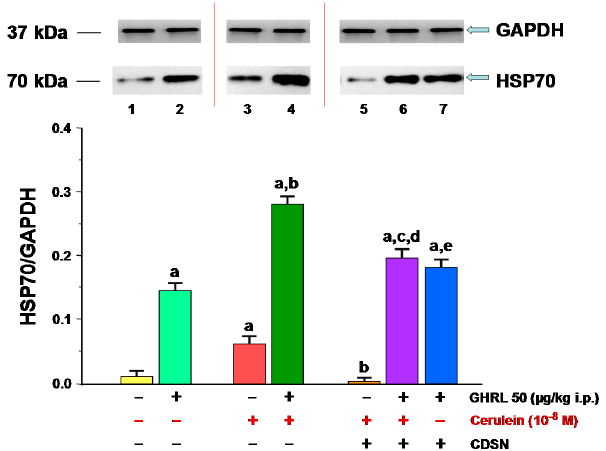
Figure 11. Analysis of the HSP70 protein synthesis determined by the method of immunoblotting and densitometric analysis of TNF- α /GAPDH protein ratio in isolated pancreatic acinar cells : (lane 1) acinar cells obtained from control sensory nerves (SN)-intact rats treated with saline, after isolation, acinar cells incubated in cerulein-free solution; (lane 2) acinar cells obtained from SN-intact rats treated with ghrelin (GHRL), after isolation, acinar cells incubated in cerulein-free solution; (lane 3) acinar cells obtained from SN-intact rats treated with saline, after isolation, acinar cells incubated in solution containing cerulein at a concentration of 10 − 8 M; (lane 4) acinar cells obtained from SN-intact rats treated with GHRL, after isolation, acinar cells incubated in solution containing cerulein at a concentration of 10 − 8 M; (lane 5) acinar cells obtained from rats with capsaicin deactivation of SN (CDSN) and treated with saline, after isolation, acinar cells incubated in solution containing cerulein at a concentration of 10 − 8 M; (lane 6) acinar cells obtained from rats with CDSN and treated with GHRL, after isolation, acinar cells incubated in solution containing cerulein at a concentration of 10 − 8 M; (lane 7) acinar cells obtained from rats with CDSN and treated with GHRL, after isolation, acinar cells incubated in cerulein-free solution. a p < 0.05 compared to control acinar cells obtained from rats with intact SN (lane 1); b p < 0.05 compared to acinar cells stimulated with cerulein after isolation from SN-intact rats treated with saline (line 3); c p < 0.05 compared to acinar cells stimulated with cerulein after isolation from rats with CDSN and treated with saline (lane 5); d p < 0.05 compared to acinar cells stimulated with cerulein after isolation from SN-intact rats treated with GHRL (lane 4); e p < 0.05 compared to acinar cells incubated in cerulein-free solution after isolation from SN-intact rats treated with GHRL (lane 2). In each experimental group, there was at least six observations.